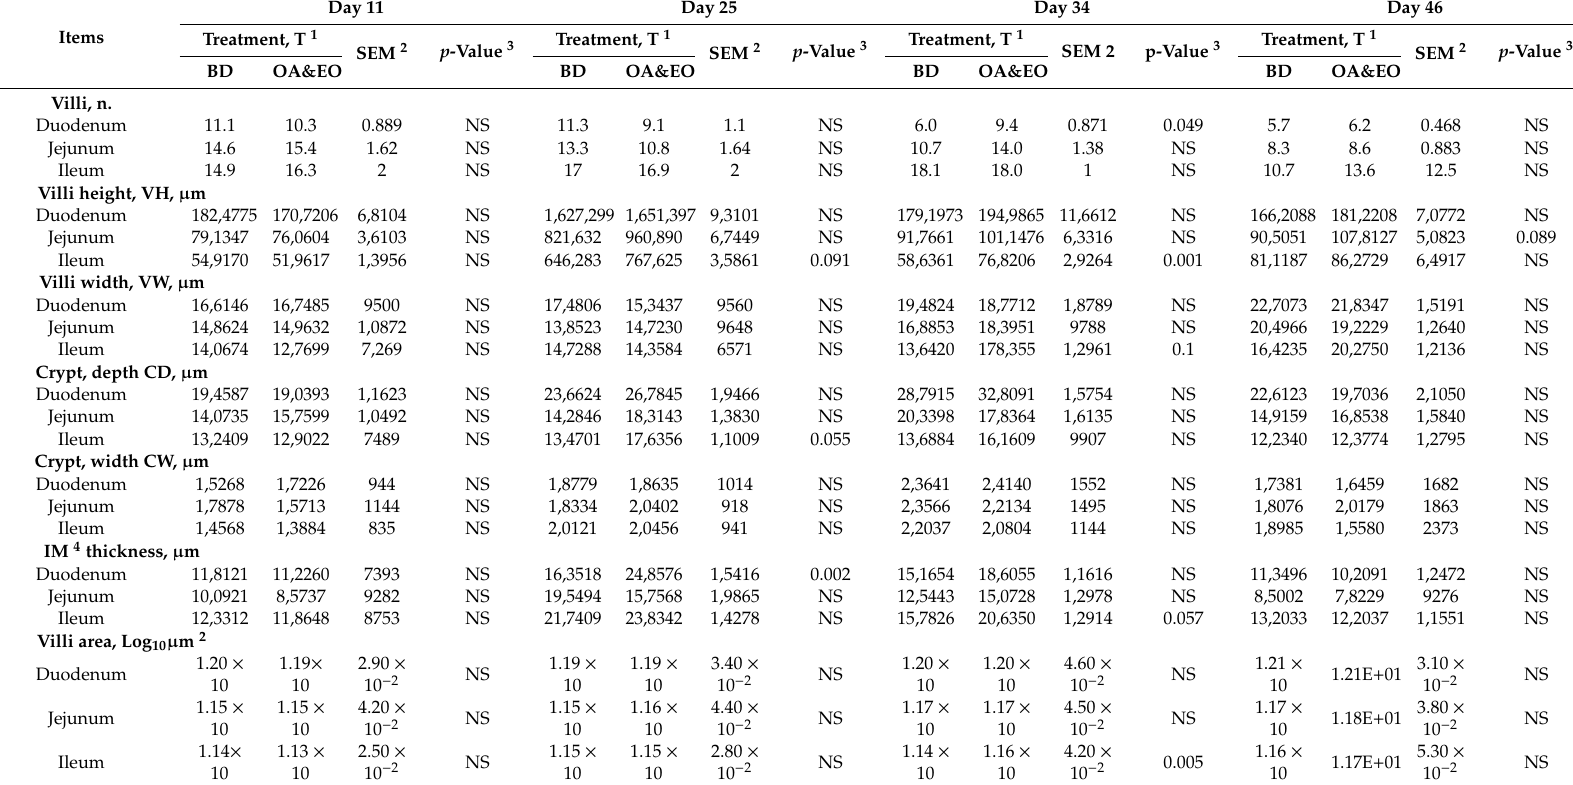
Table 4. Intestinal morphometric analysis as a ff ected by dietary treatment, sampling time and intestinal section (n = 9 for each treatment within sampling